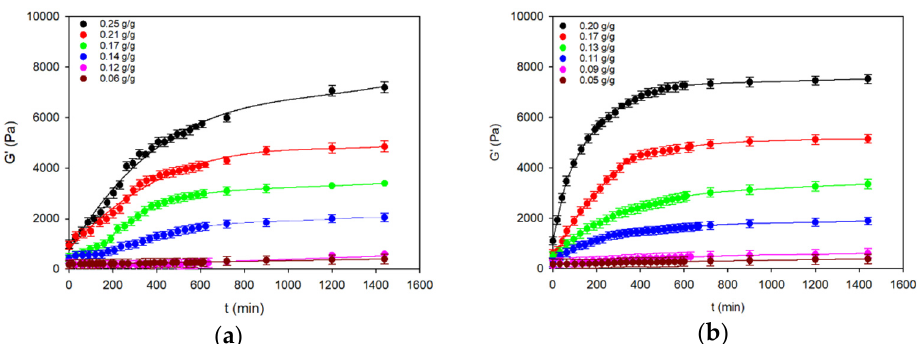
Figure 1. The kinetics of the storage modulus (G’) in the process of formation of starch gels ( a ) and starch–fat emulsions ( b ). The values are expressed as means ± SD ( n = 3).